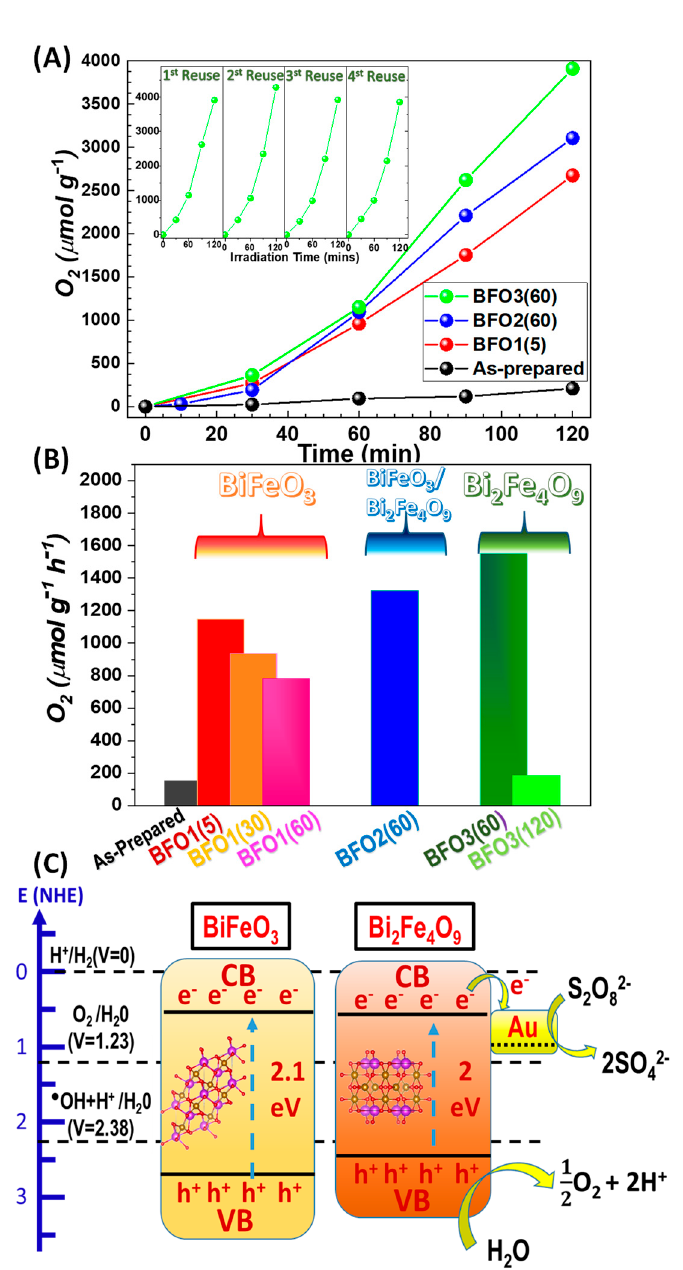
Figure 5. ( A ) Kinetics of photocatalytic O 2 production by the BFO photocatalysts. Inset, Reuse study of the BFO3(60) photocatalyst. ( B ) The photocatalytic O 2 -production per h, for all the studied BFO. ( C ) a reaction scheme of the photocatalytic reaction process.